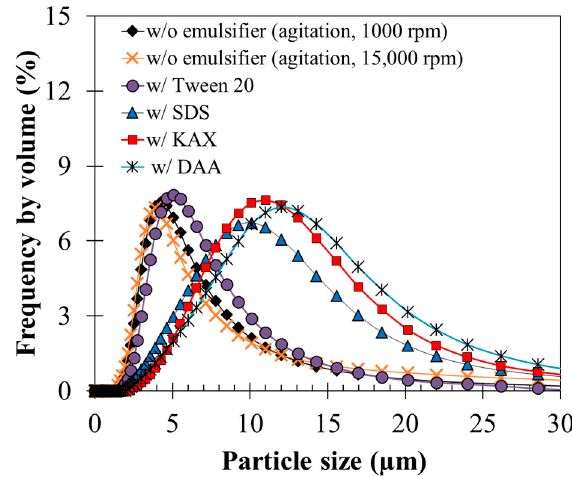
Figure 6. Size distribution after agglomeration (agglomeration conditions: 30 min; 1000 rpm with emulsifiers, 1000 and 15,000 rpm without emulsifiers).